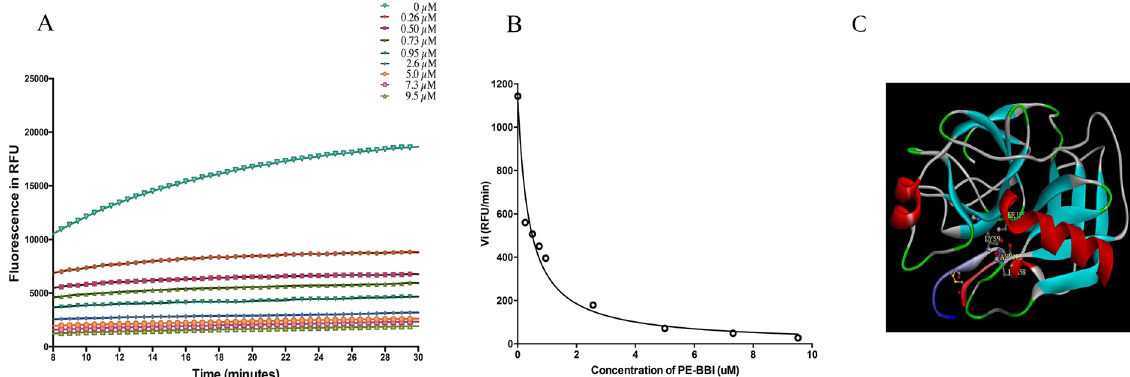
Figure 2. ( A ) Dose-dependent PE-BBI curves for trypsin proteolysis inhibitory assay. The x-axis represents time in minutes and the y-axis represents fluorescence intensity. ( B ) Morrison plots of PE-BBI, the initial rate (vi) values at each concentration of PE-BBI (0.1 to 100 µ M). RFU/min (relative fluorescence units/min). ( C ) Possible interactions model between bovine trypsin protease and PE-BBI. The active site of trypsin (His 58 , Asp 102 , and Ser 195 ) and the active site of PE-BBI (Lys 9 ) were performed in stick representation. The disulphide bond of PE-BBI was showed in stick representation (Orange).